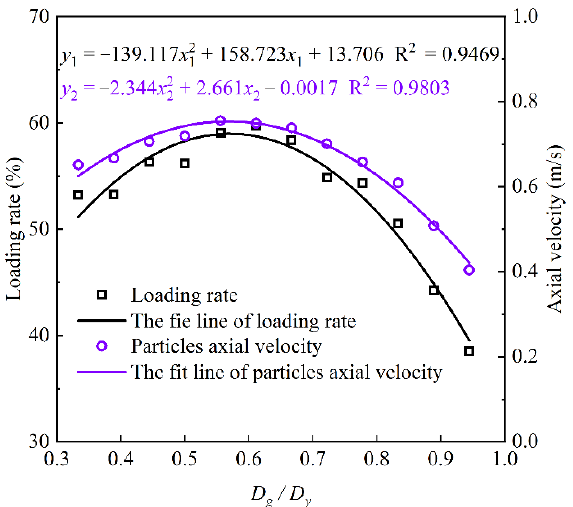
Figure 13. The load ing rate and particles’ axial velocities versus barrel diameter in ejection mode ( D y = 900 mm).